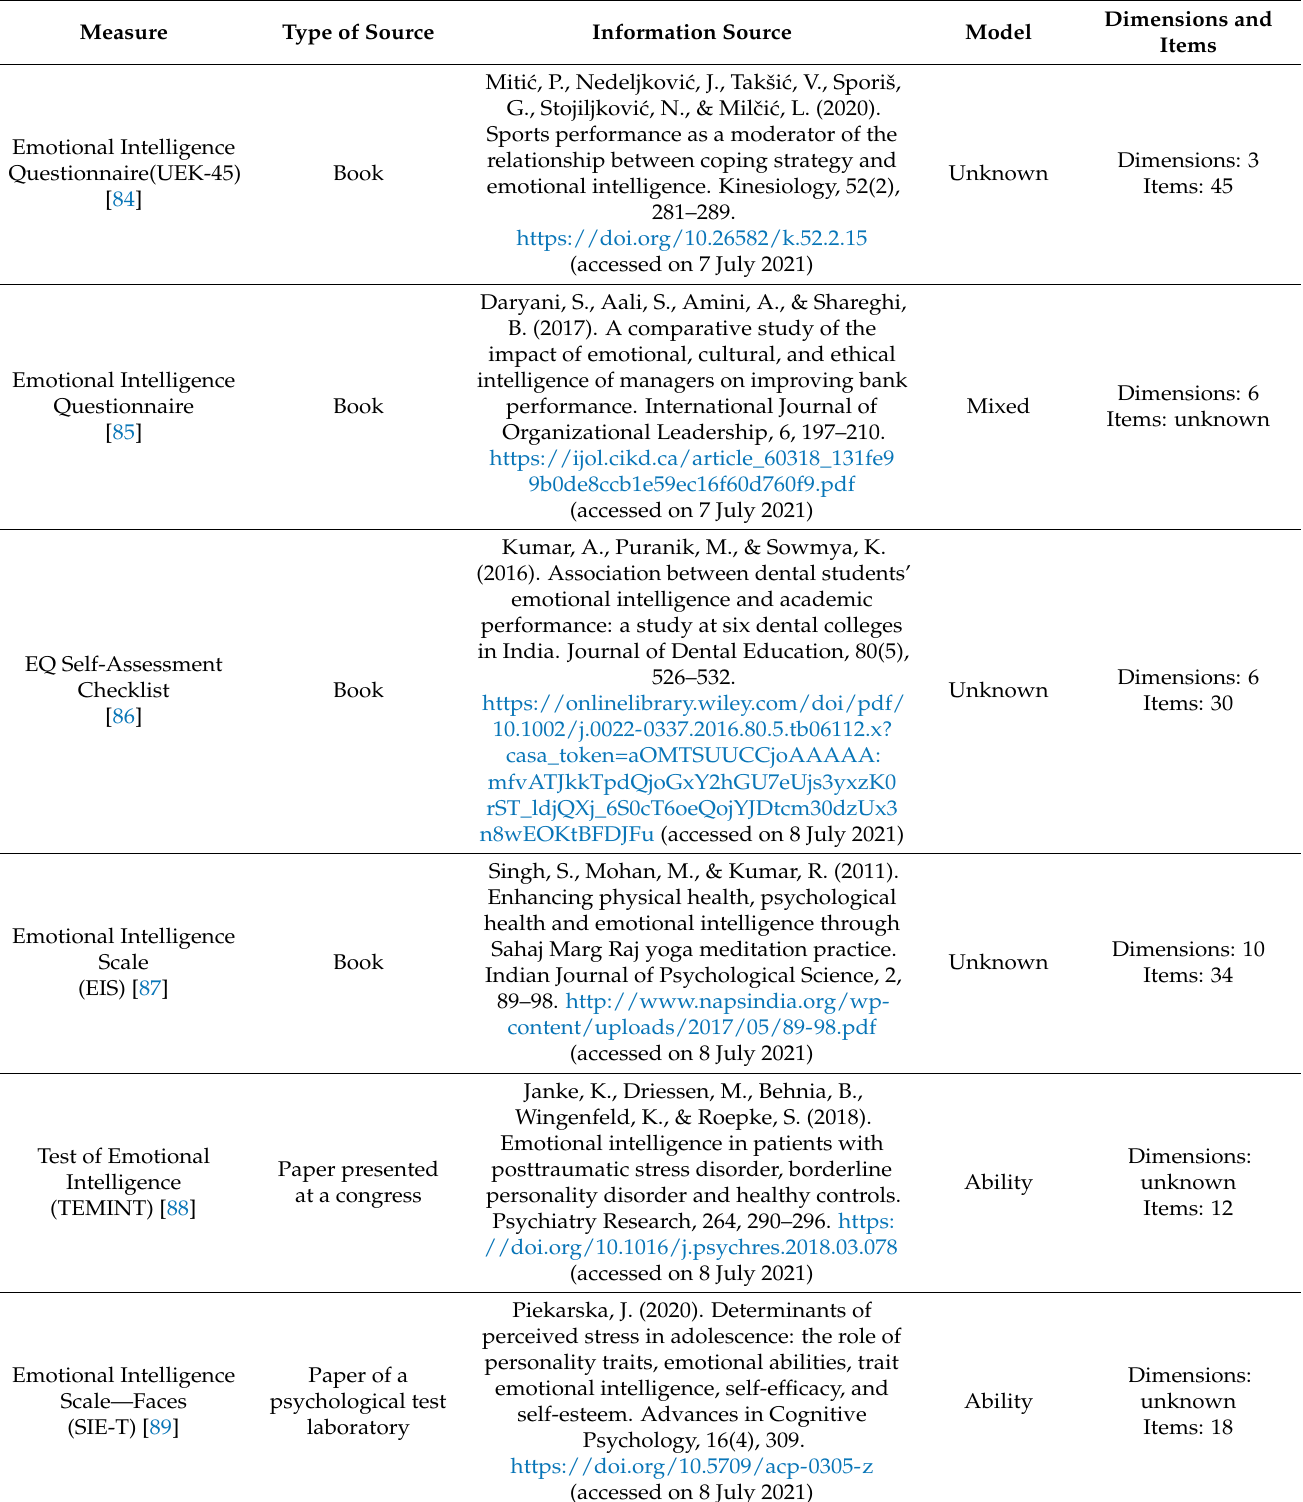
Table 3. Information of the non-accessible